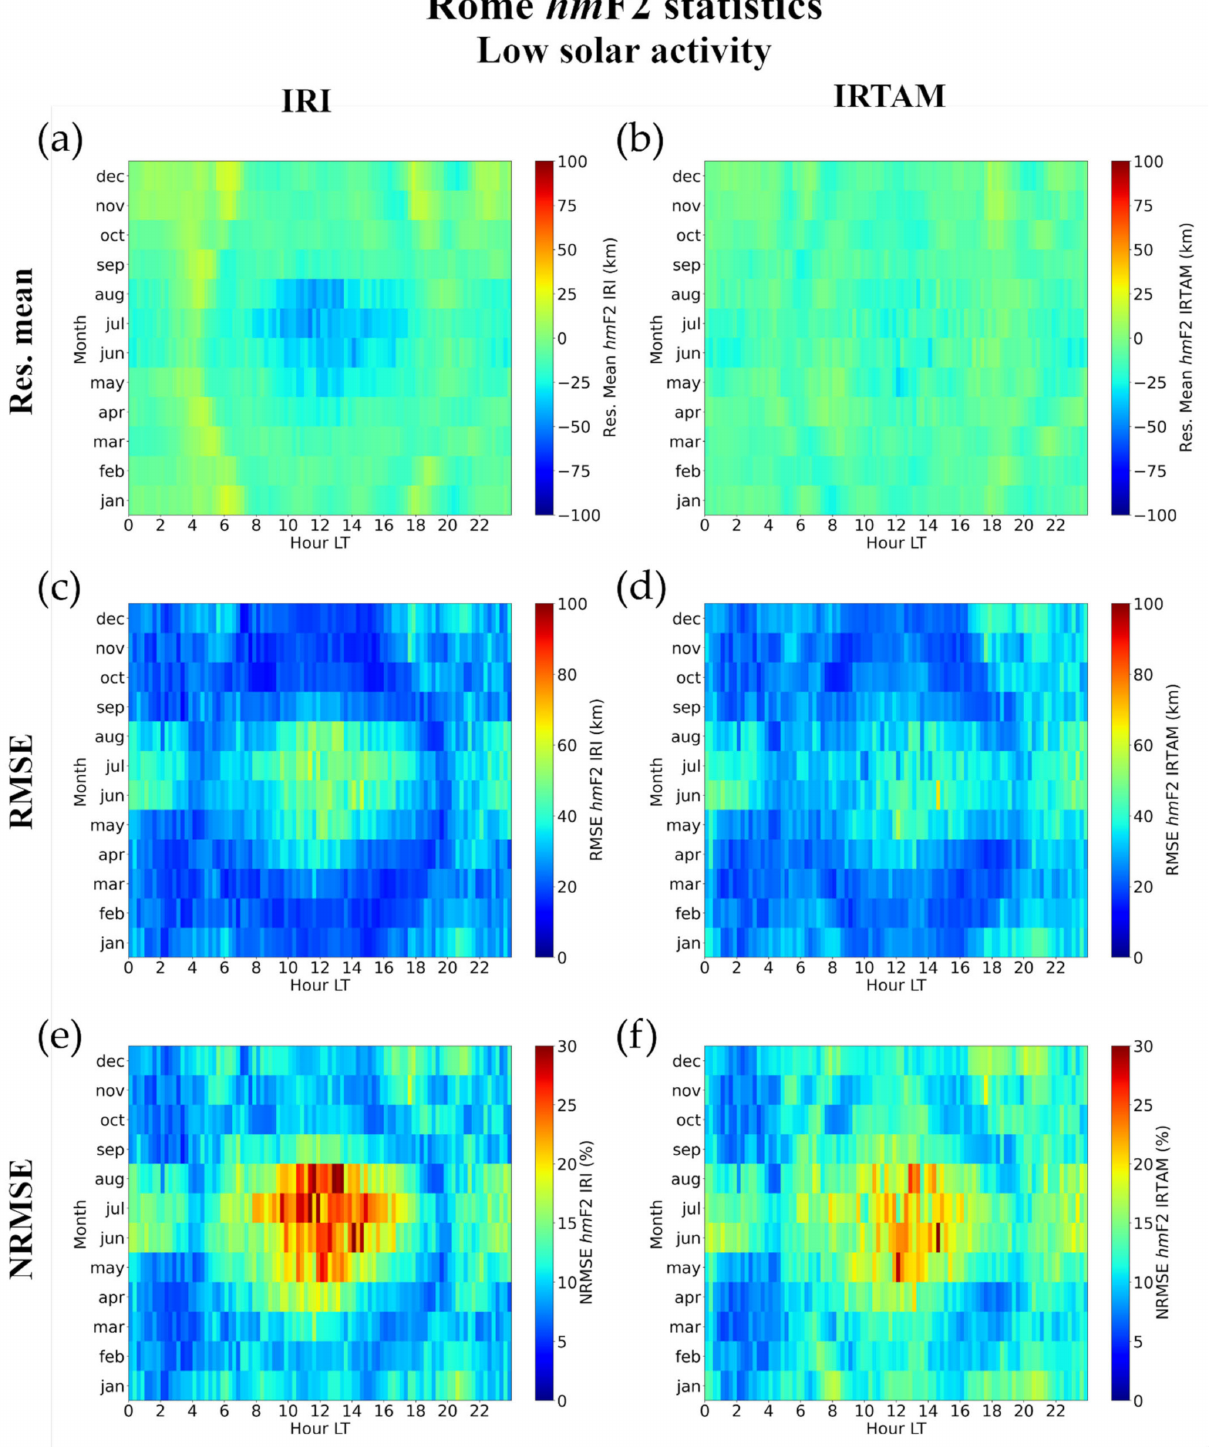
Figure 31. Same as Figure 25 but for